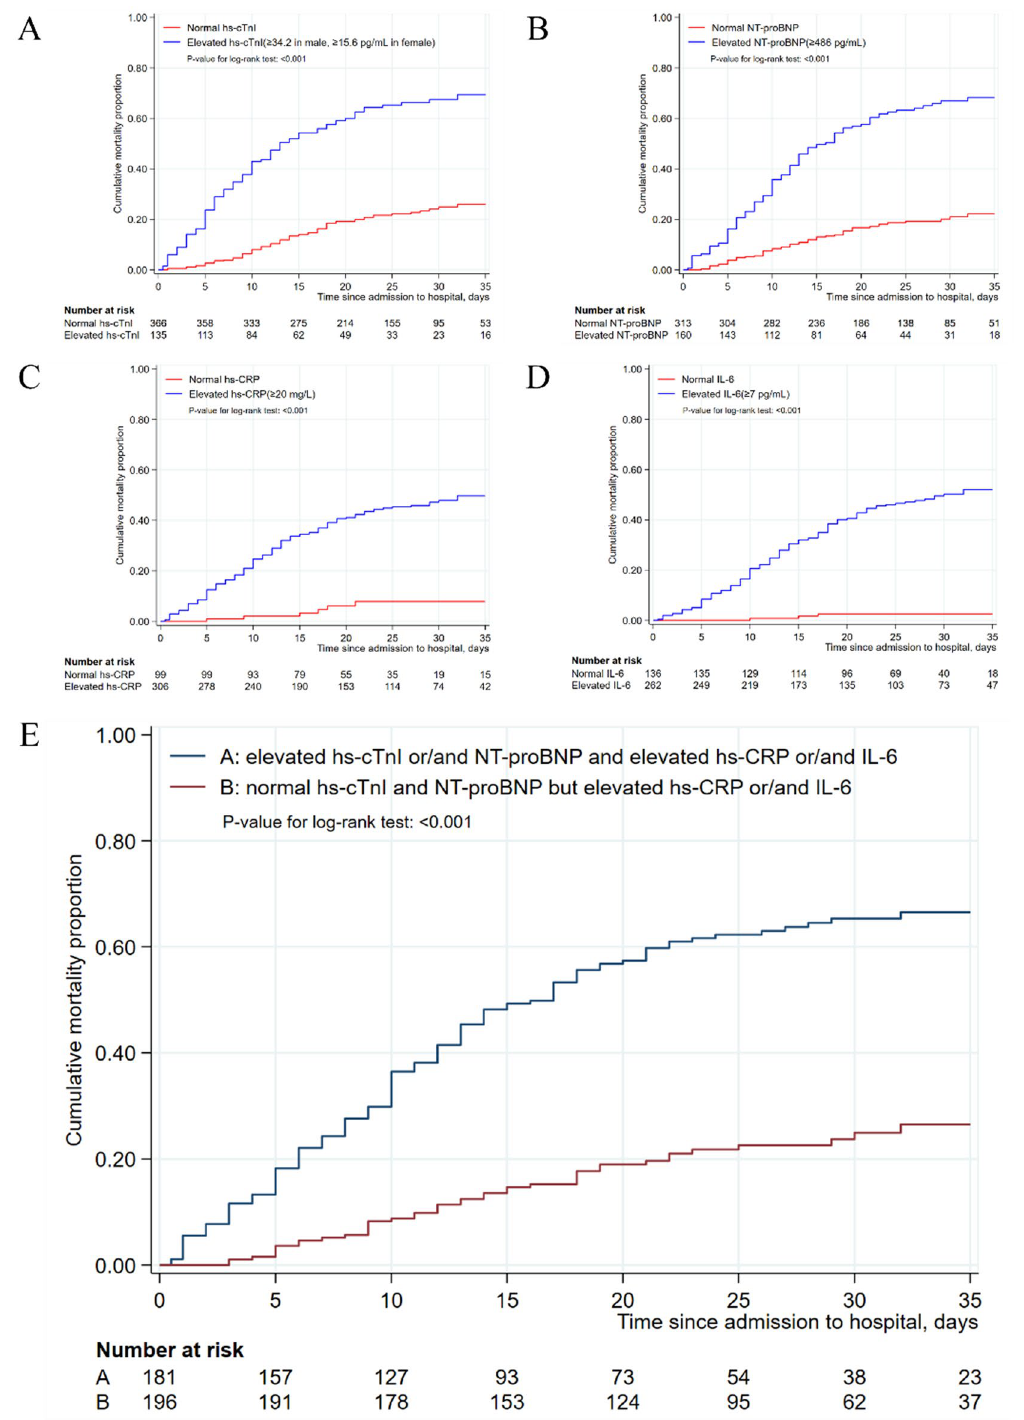
Figure 1. Cumulative mortality rates among severe patients with COVID-19 according to the values of hs-cTnI, hs-CRP, NT-proBNP and IL-6. ( A ) Kaplan–Meier estimates representing the probability of death in the hospital according to the value of hs-cTnI; ( B ) Kaplan–Meier estimates representing the probability of death in the hospital according to the value of NT-proBNP; ( C ) Kaplan–Meier estimates representing the probability of death in the hospital according to the value of hs-CRP; ( D ) Kaplan–Meier estimates representing the probability of death in the hospital according to the value of IL-6. ( E ) Kaplan–Meier estimates representing the comparisons of probability of death in the hospital between two groups. A: elevated hs-cTnI or/and NT-proBNP and elevated hs-CRP or/and IL-6, B: normal hs-cTnI or/and NT-proBNP but elevated hs-CRP and